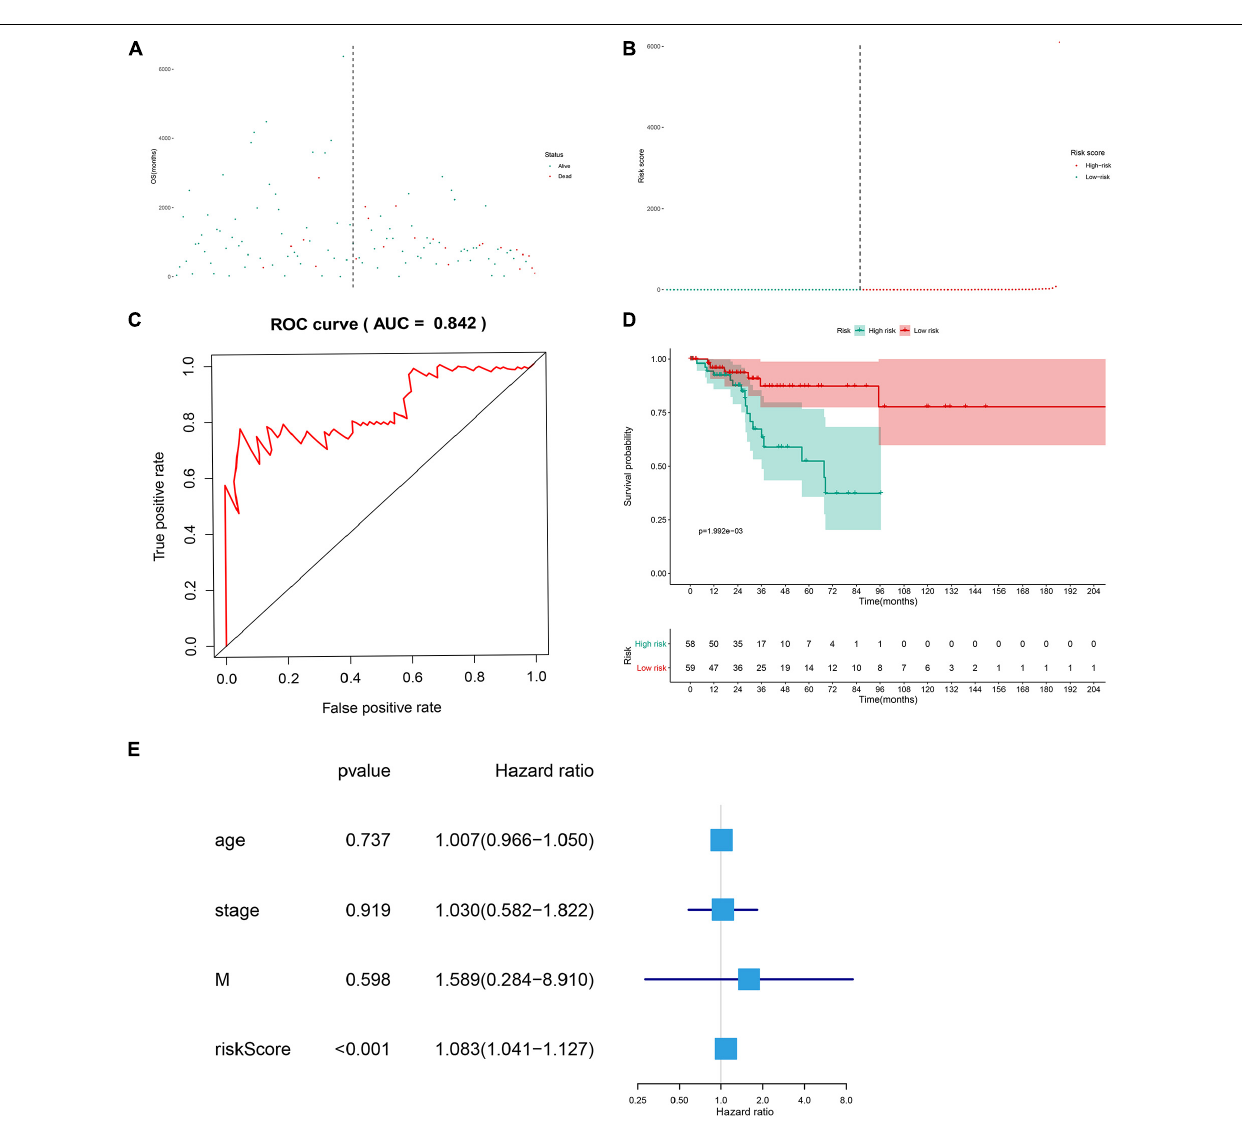
FIGURE 5 | The scatter plot of the samples (A) , the risk curve of each sample reordered by risk score (B) , green and red represent low risk and high risk groups, respectively. ROC curve (AUC = 0.921) for prognostic DESRGs (C) . Overall survival Kaplan–Meier curve for prognostic DEMRGs ( p < 0.001) (D) . Univariate Cox regression models indicated the risk score was an independent prognostic factor (E)